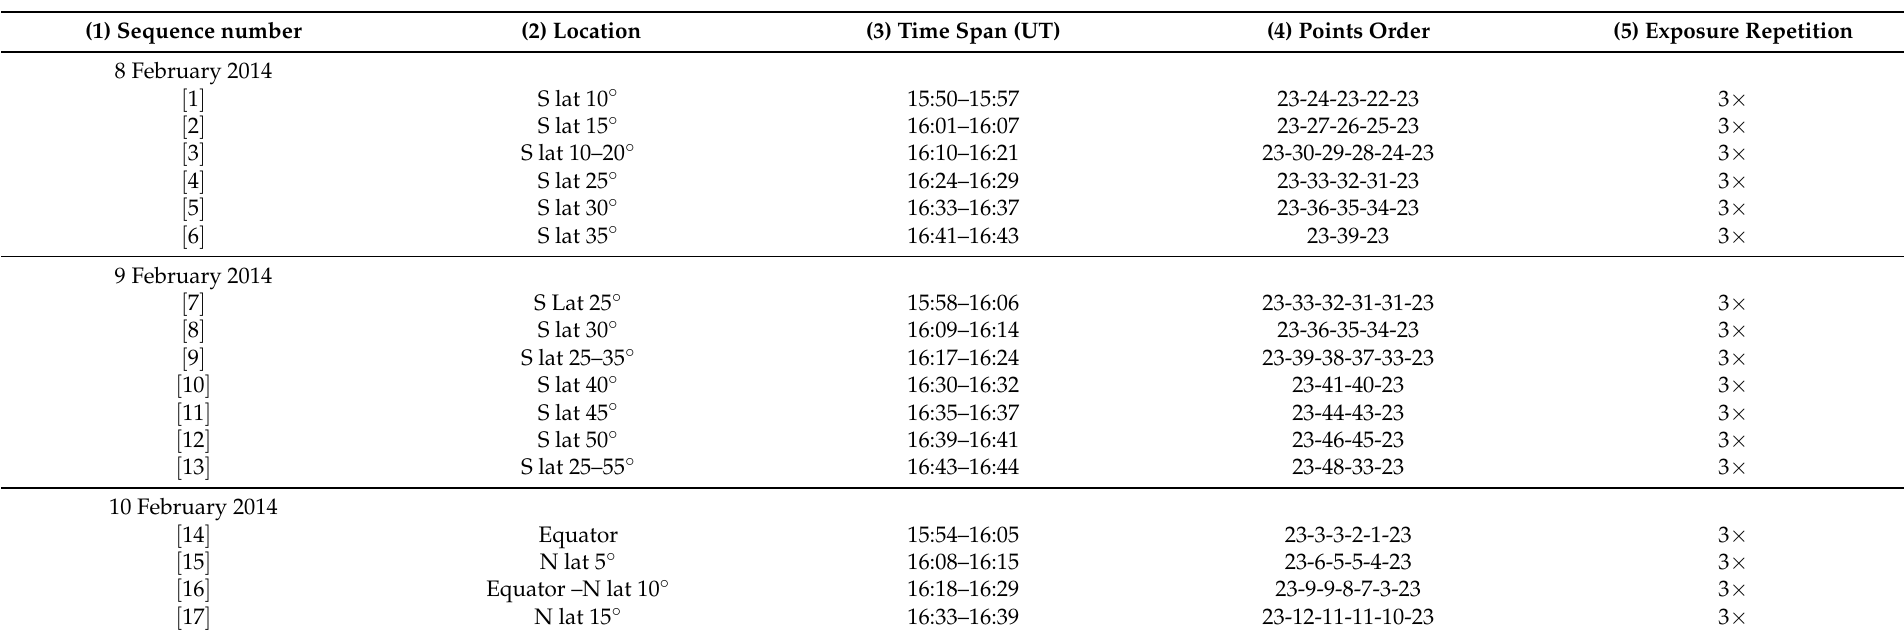
Table 4. Scanning sequences on Venus’ dayside hemisphere using CFHT/ESPaDOnS during the 8–10 February 2014 observing run: (1) sequence number; (2) location on disk; (3) UT time interval; (4) points’ acquisition order; (5) exposure repetition: each point is acquired 3 times to check for internal